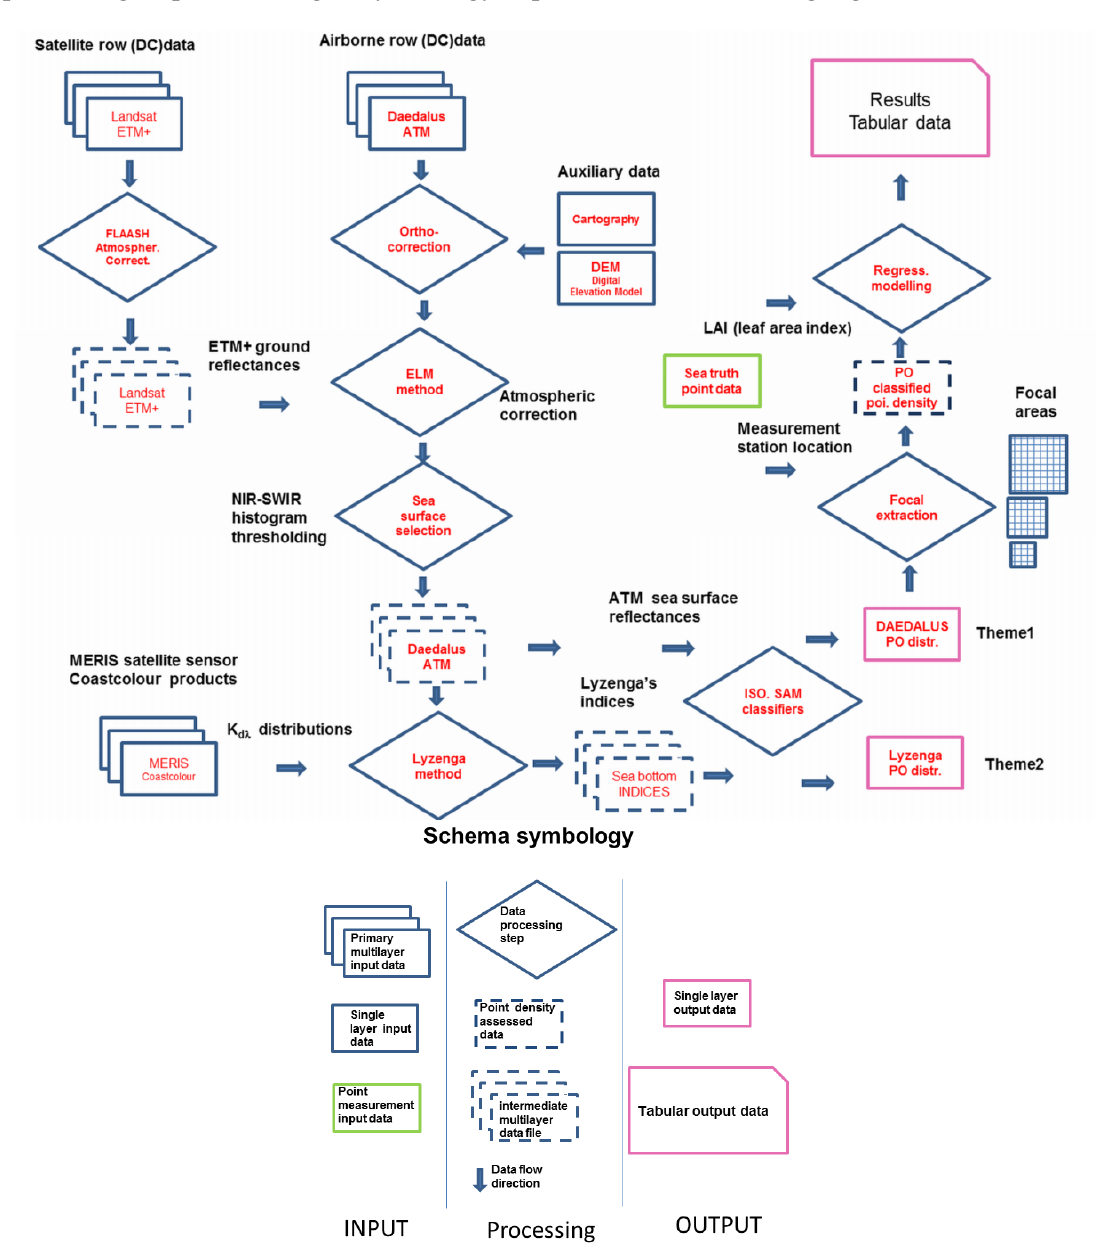
Figure 1. Implemented methodology scheme describing the input/output data and processing steps according to symbology explained in the following